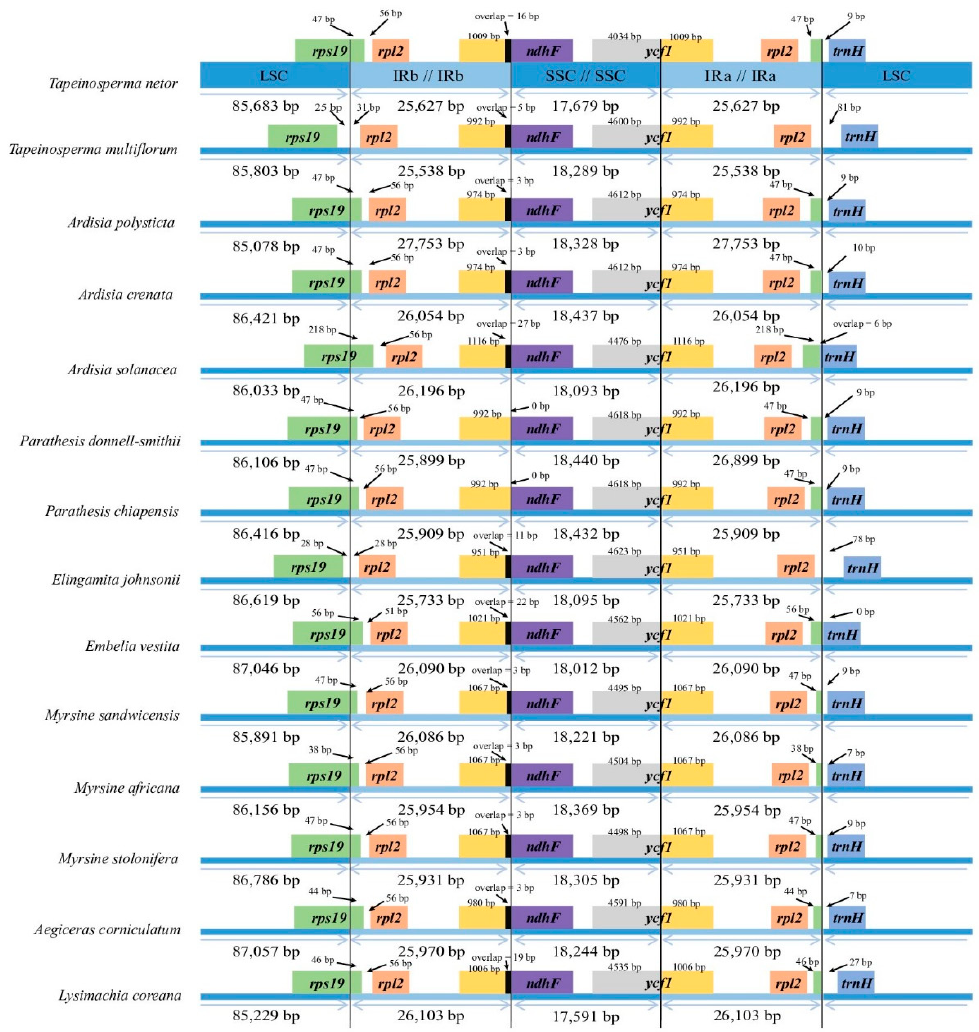
Figure 2. Comparisons of the boundaries between large single-copy (LSC), small single-copy (SSC), and inverted repeat (IR) regions among different Myrsinoideae cp genomes.